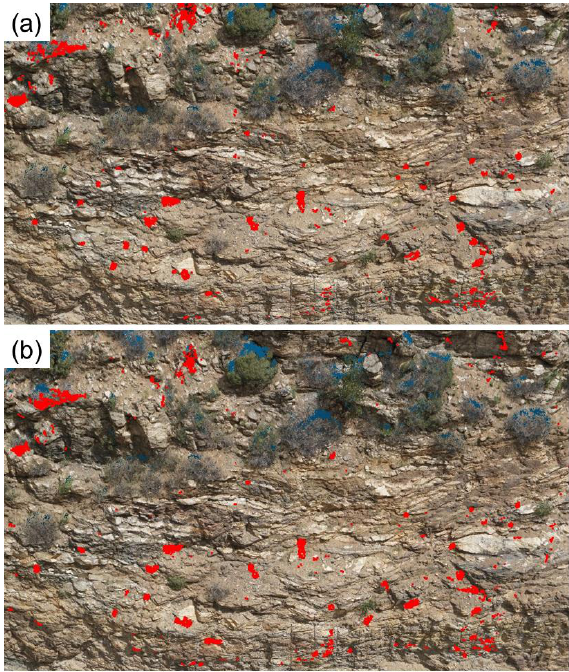
Figure 7. Detected rock changes (a) TP (2018) versus TP (2019) using 13 GCPs; (b) TP (2018) versus sUAS (2019; 0 GCPs and pre-calibration) using the developed algorithm.